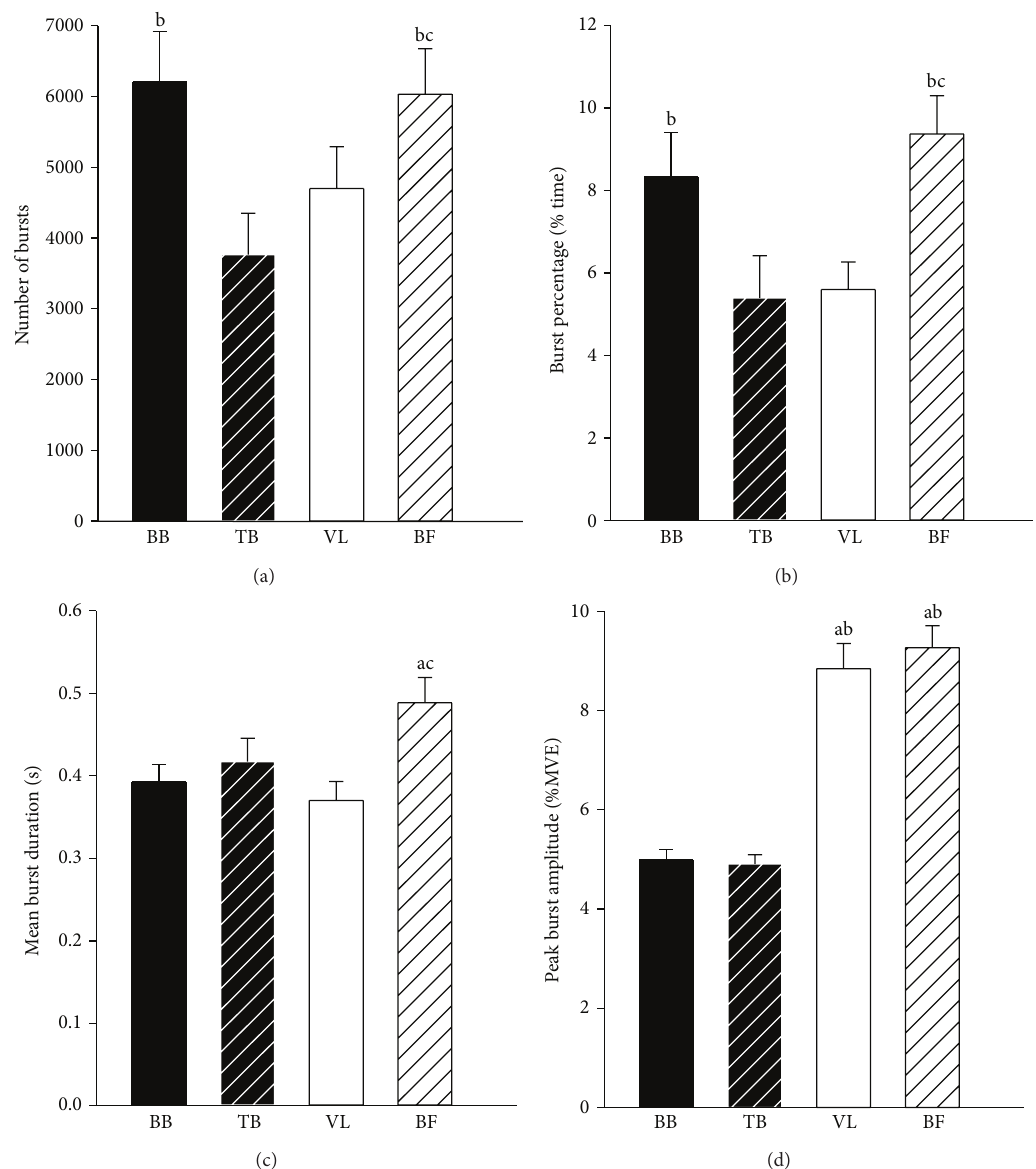
Figure 1: Muscle effect on burst characteristics for young adults. (a) Number of bursts; (b) burst percentage; (c) mean burst duration; (d) peak burst amplitude. BB: biceps brachii; TB: triceps brachii; VL: vastus lateralis; BF: biceps femoris; sec: seconds; %: percentage; MVE: maximal voluntary exertion. a Significantly different from BB; b significantly different from TB; c significantly different from VL.